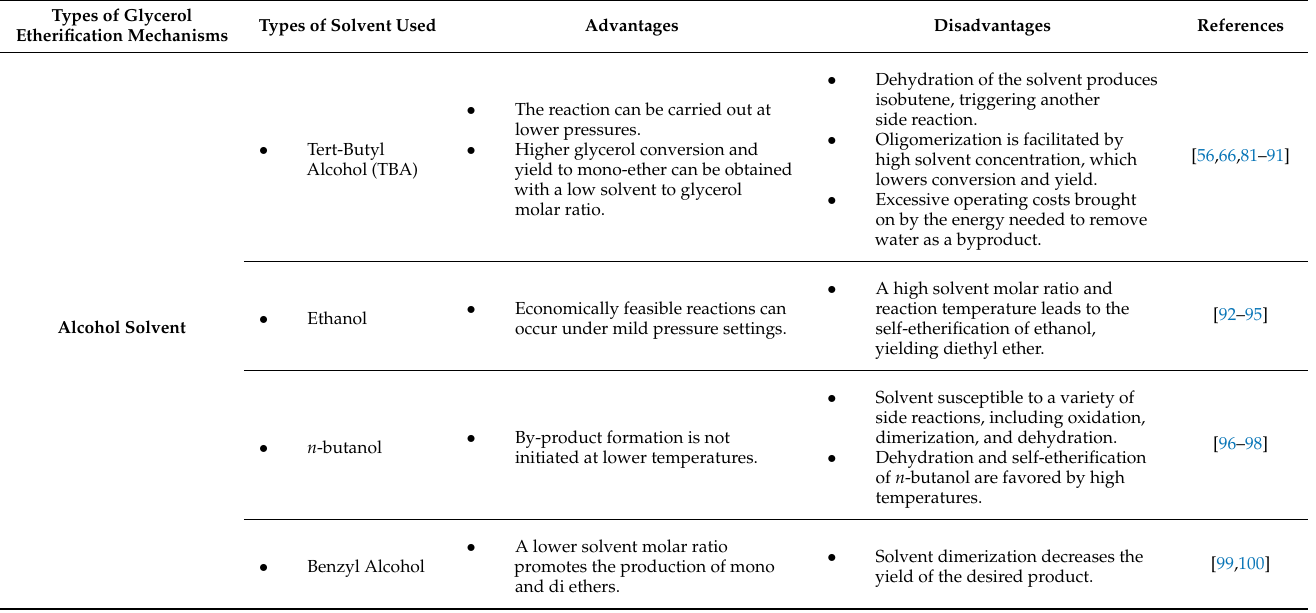
Figure 4. Types of reaction mechanisms for glycerol etherification. Table 2. Advantages and disadvantages of solvent and solvent free approach.